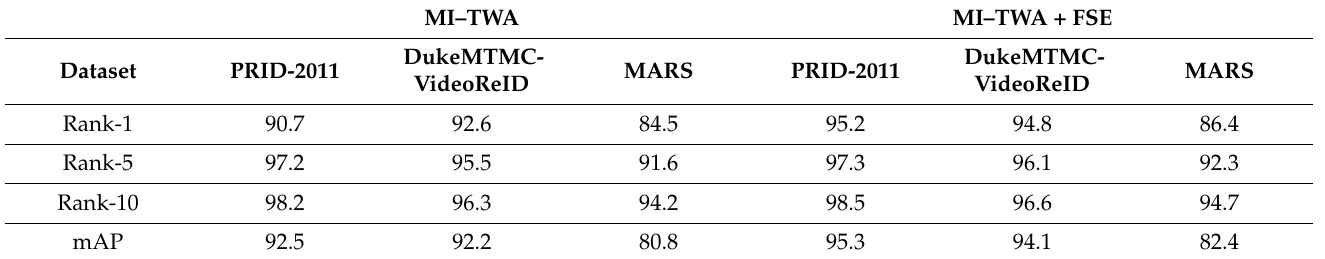
Table 3. Comparison between Baseline + MI–TWA+FSE and Baseline + MI–TWA models. The Rank-i CMC accuracies and mAP scores are